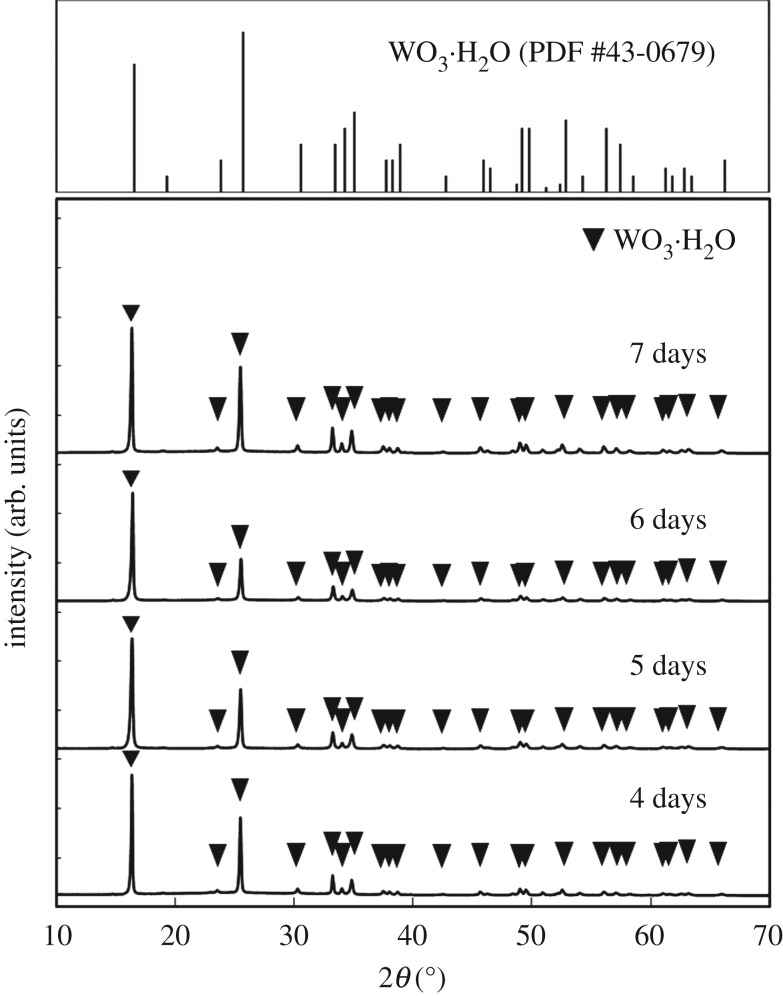
XRD patterns of WO3 precursors prepared by ageing for 4–7 days from (NH4)10W12O41 solutions with Cge = 2.0 g l−1 and HCl at pH 1.0.